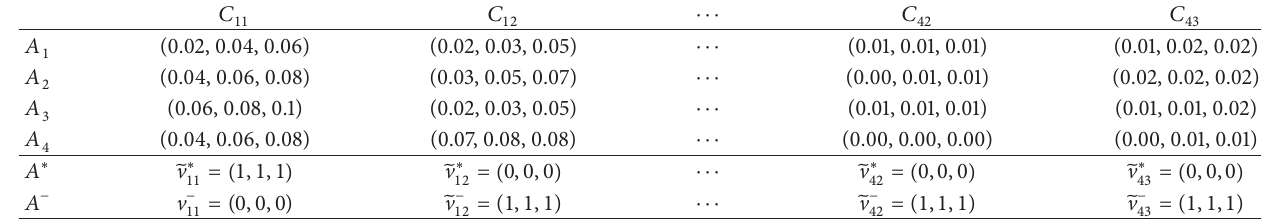
Table 8: Weighted evaluation matrix for the alternatives.